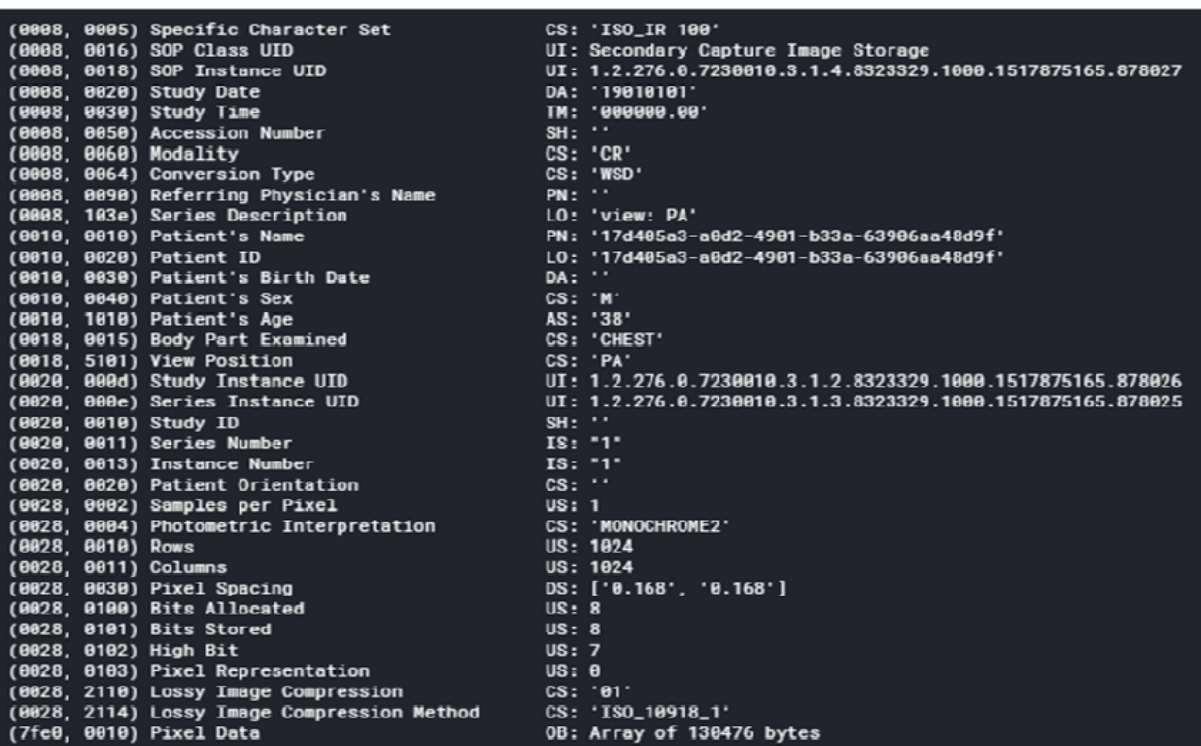
Figure 1. Snapshot of metadata stored in a DICOM Image.